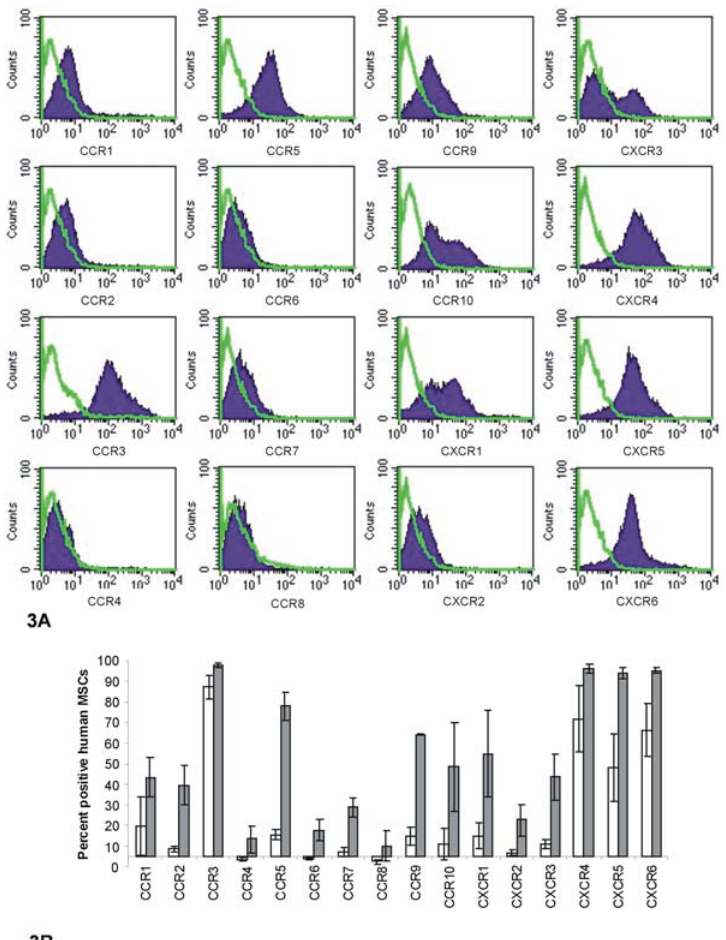
Figure 3. Analysis of chemokine receptor expression on human MSCs. A Flow cytometry analysis of chemokine receptor expression on the cell surface of human MSCs. Chemokine receptor antibody staining is represented by the filled histogram; isotype control staining is represented by the green line. Histograms are representative of three different patients’ cells, all removed from flasks by EDTA alone. B Mean percentage positive MSCs is shown for each receptor ( 6 SE, n=3) detected by flow cytometry on the surface of human MSCs removed from the flask by trypsin-EDTA (white bars), or by EDTA alone (grey bars).